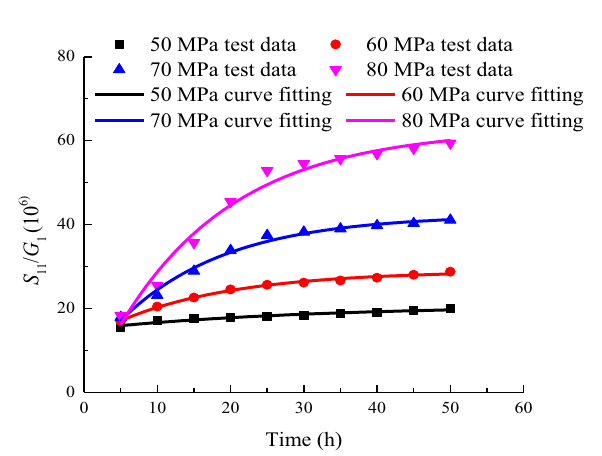
Figure 13. Fitting of S 11 / G 2 contrast experiment curves when σ 3 = 15 MPa.